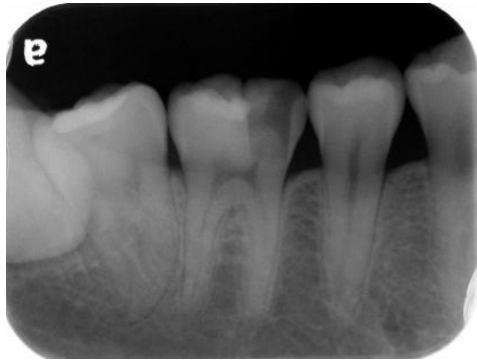
Figure 2. Pre-operative periapical radiograph shows caries in proximity to the pulp horn.